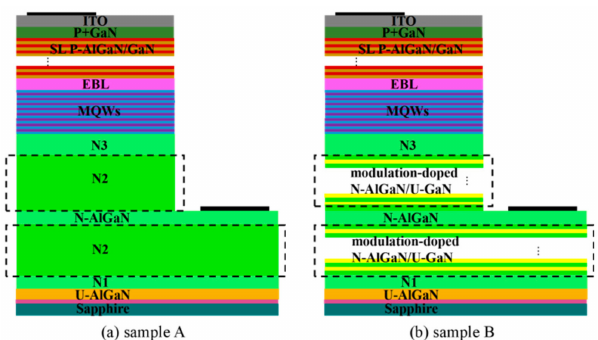
Figure 1. Schematic structures of the ( a ) conventional Sample A and ( b ) Sample B with a multi-layer stacking structure.